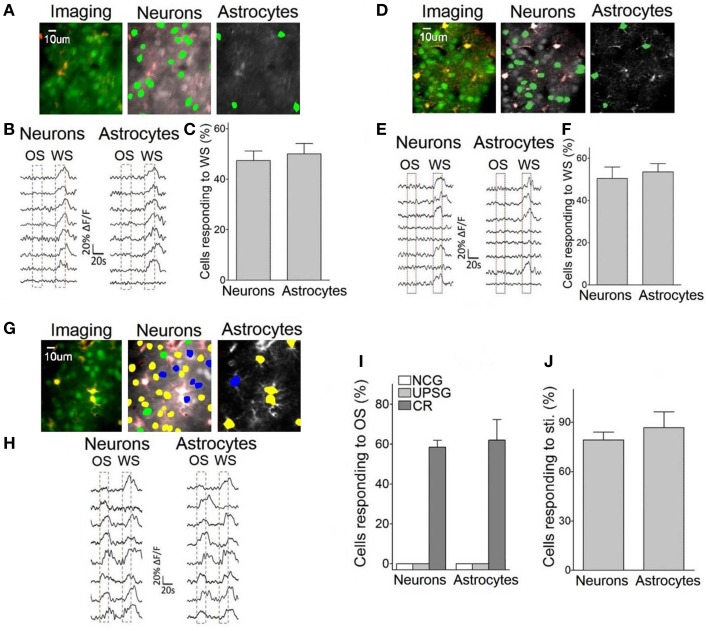
Neurons and astrocytes in the barrel cortex respond to the odor-test after pairing OS and WS. Cellular activities were detected by imaging Ca2+ signals under the two-photon microscope in the light anesthesia mice from NCG (n = 5), UPSG (n = 7), and CR-formation (n = 5), in which the astrocytes were labeled by SR101 (red). Panels (A–C) are from NCG mice, (D–F) are from UPSG, and (G–J) are from CR-formation. (A) Illustrates Ca2+ imaging (left panel, green for neurons, and red for astrocytes), neurons (middle) and astrocytes (right) in response to WS from a NCG mouse. (B) Illustrates Ca2+ signals from the neurons (left) and astrocytes (right) by giving OS and WS (red dash-line boxes) to a NCG mouse, in which they respond to WS only. (C) Shows the percentages of the neurons and astrocytes in response to WS from NCG mice (n = 5). (D) Illustrates Ca2+ imaging (left panel, green for neurons, and red for astrocytes), neurons (middle), and astrocytes (right) in response to WS from a UPSG mouse. (E) Illustrates Ca2+ signals from the neurons (left) and astrocytes (right) by giving OS and WS (red dash-line boxes) to a UPSG mouse, in which they respond to WS only. (F) Illustrates the percentages of the neurons and astrocytes in response to WS from UPSG mice (n = 7). (G) Shows Ca2+ imaging (left panel, green for neurons, and red for astrocytes), neurons (middle), and astrocytes (right) from a CR-formation mouse. The neurons and astrocytes responding to both OS and WS are labeled as yellow. Those responding to OS or WS only are labeled by blue or green. (H) Illustrate Ca2+ signals in the neurons (left) and astrocytes (right) responding to OS and WS from a CR-formation mouse. (I) Shows the portions of neurons (58.47 ± 7.8%) and astrocytes (62 ± 23.1%) in response to OS from CR-formation mice (dark-gray bars), compared with zero in NCG (white) and UPSG (light-gray). (J) The portions of the neurons and astrocytes in response to all stimuli from CR-formation mice (n = 5) are 79.3 ± 4.72 and 86.67 ± 9.72% of the OGB-detected cells, respectively.